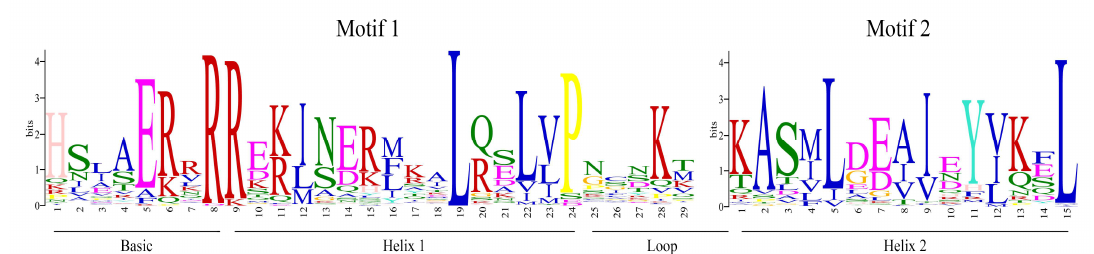
Figure 3. Logo consensus sequences of bHLH subfamily from Cannabis. Logo sequences of motif 1 and 2 represent the bHLH domain in Cannabis . The overall height of each stack indicates the conservation of the sequence at a certain position. Capital letters indicate > 50% conservation of amino acids within the domains. The width of motifs is indicated by Arabic number under the colored letters, where each color represents a type of amino acid. Full sequences are listed in Supplementary Files